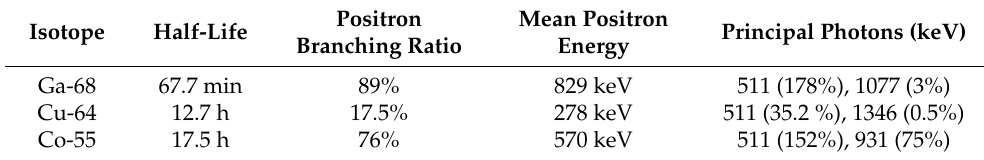
Table 1. Radionuclides used in this study.